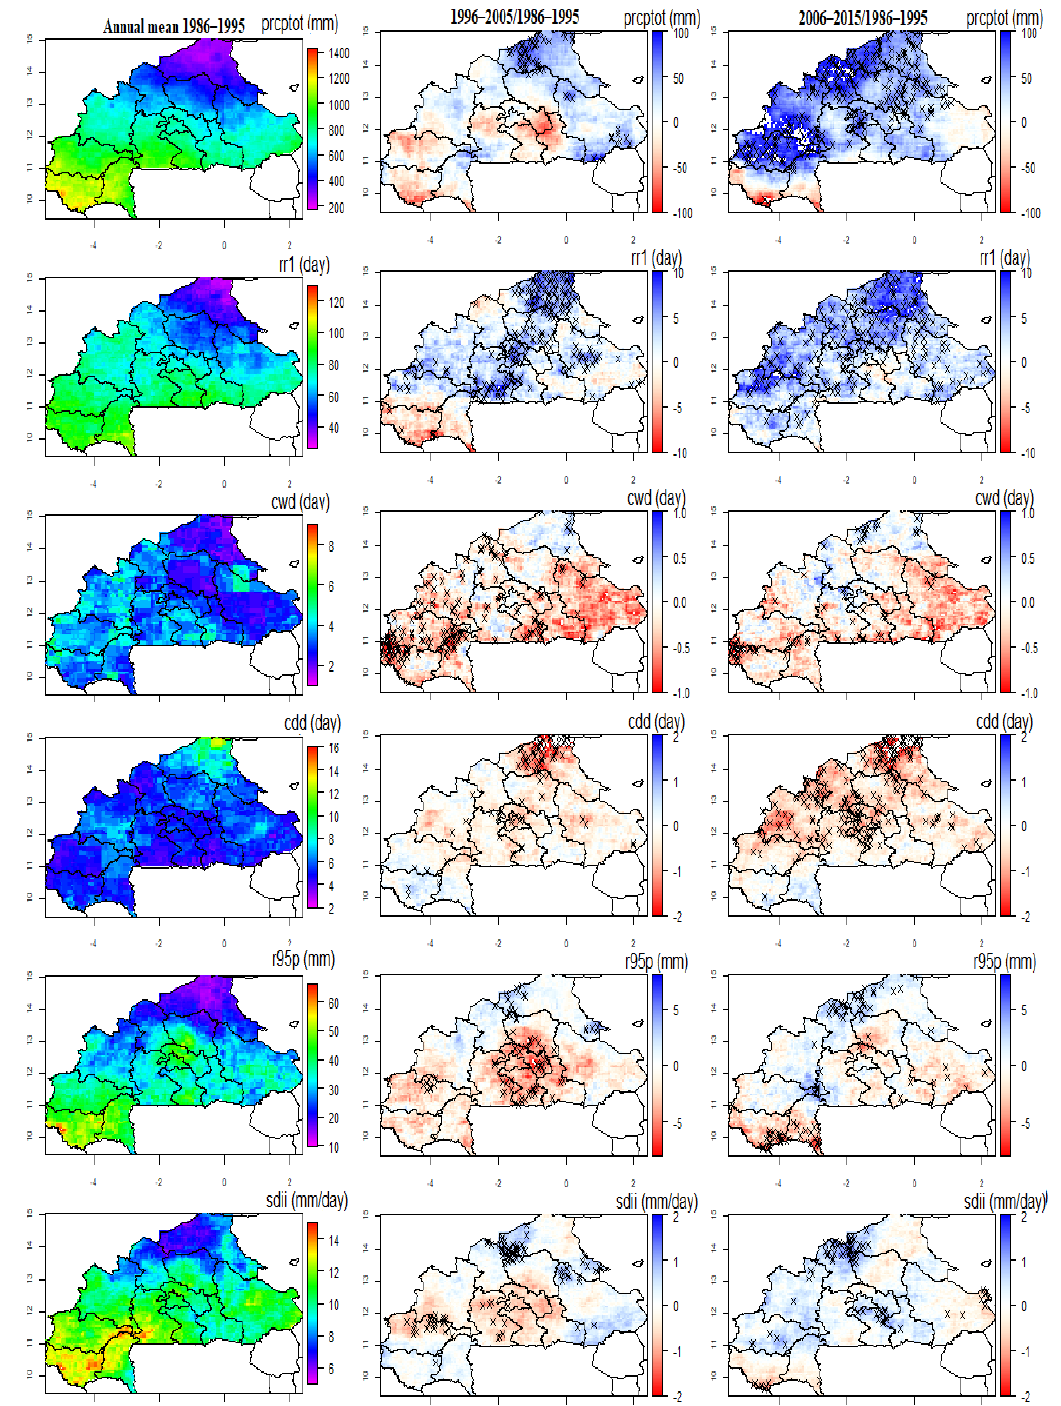
Figure 9. Spatial patterns of precipitation indices over Burkina-Faso: mean over reference decade 1986–1995 (first column); change over the 1996–2005 decade (second column) and changes over the 2006–2015 decade relative to the reference decade (third column). Areas with the symbol (x) are significant at a 95% confidence level.